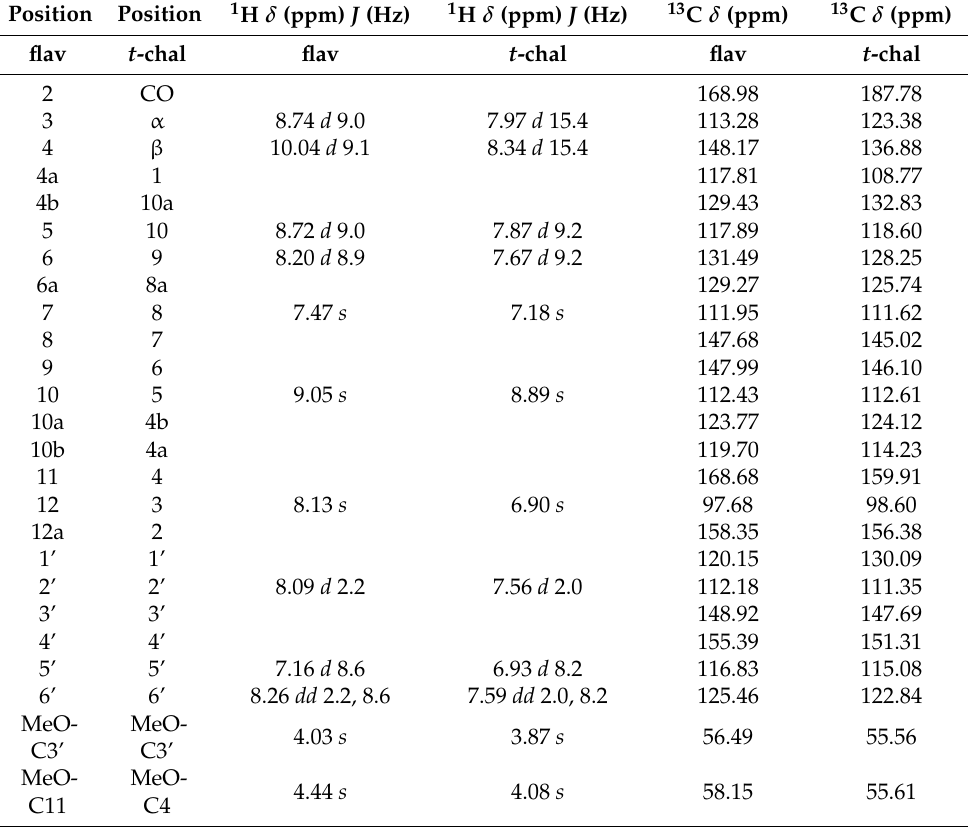
Table 1. Sphagnorubin C ( 1 ) 1 H and 13 C-NMR data of the flavylium cation form in 5% d -TFA in d -DMSO ( v / v ) and the trans -chalcone form (after 24 h of equilibration) in pure d